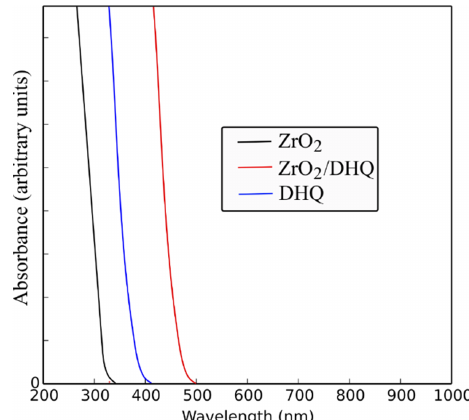
Figure 6. The electronic excitation spectra of [Zr 11 O 20 (OH) 2 ]/DHQ cluster, and its constituents, calculated by convolution with a full width at a half maximum of 3000 cm − 1 . Table 1. The energies of frontier orbitals (eV) of DHQ, [Zr 11 O 20 (OH) 4 ], and DHQ / [Zr 11 O 20 (OH) 2 ] clus- ter, the bandgap (E g ), as well as excitation energies, and the oscillator strength (ƒ) of the first three transitions calculated at TD-DFT/CAM-B3LYP/6-31G(d,p) level. Wave-functions and contributions to the electronic transitions are presented in the last column. HOMO/LUMO denote DHQ’s orbitals, while VBM and CBM are used for ZrO 2 -centered orbitals.